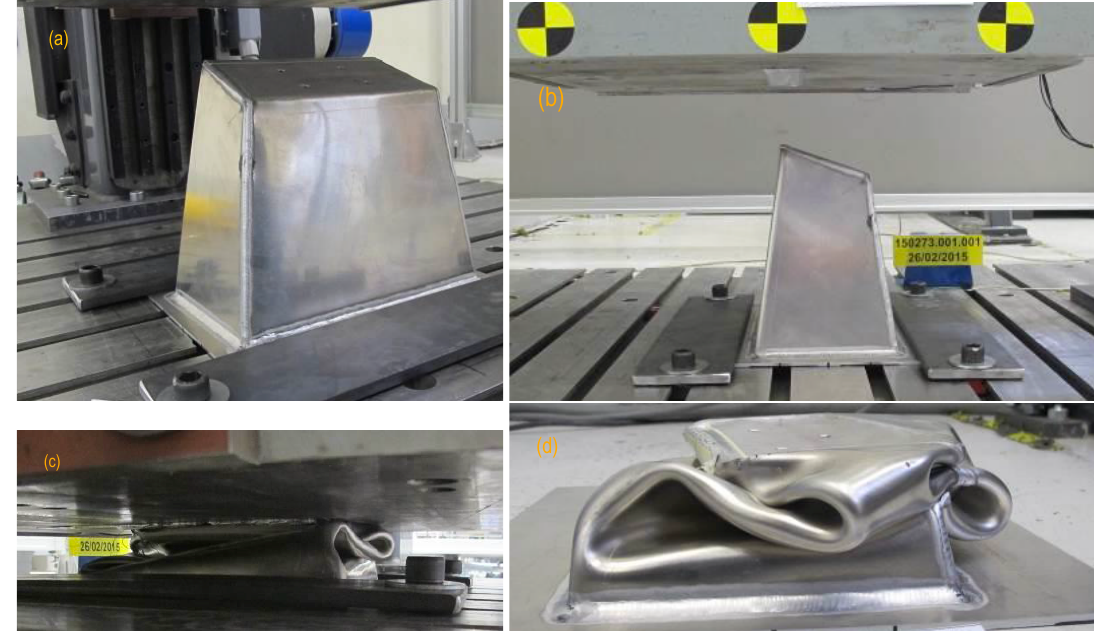
Figure 2. Pictures corresponding to the actual impact test. ( a , b ) show the Impact Attenuator fixed to the bench. The welding at the edges is clearly visible, as is the welding around the perimeter to bond the base plate. The impactor, with reference tags, is also visible; ( c , d ) show the piece after the test. The final height was about 60